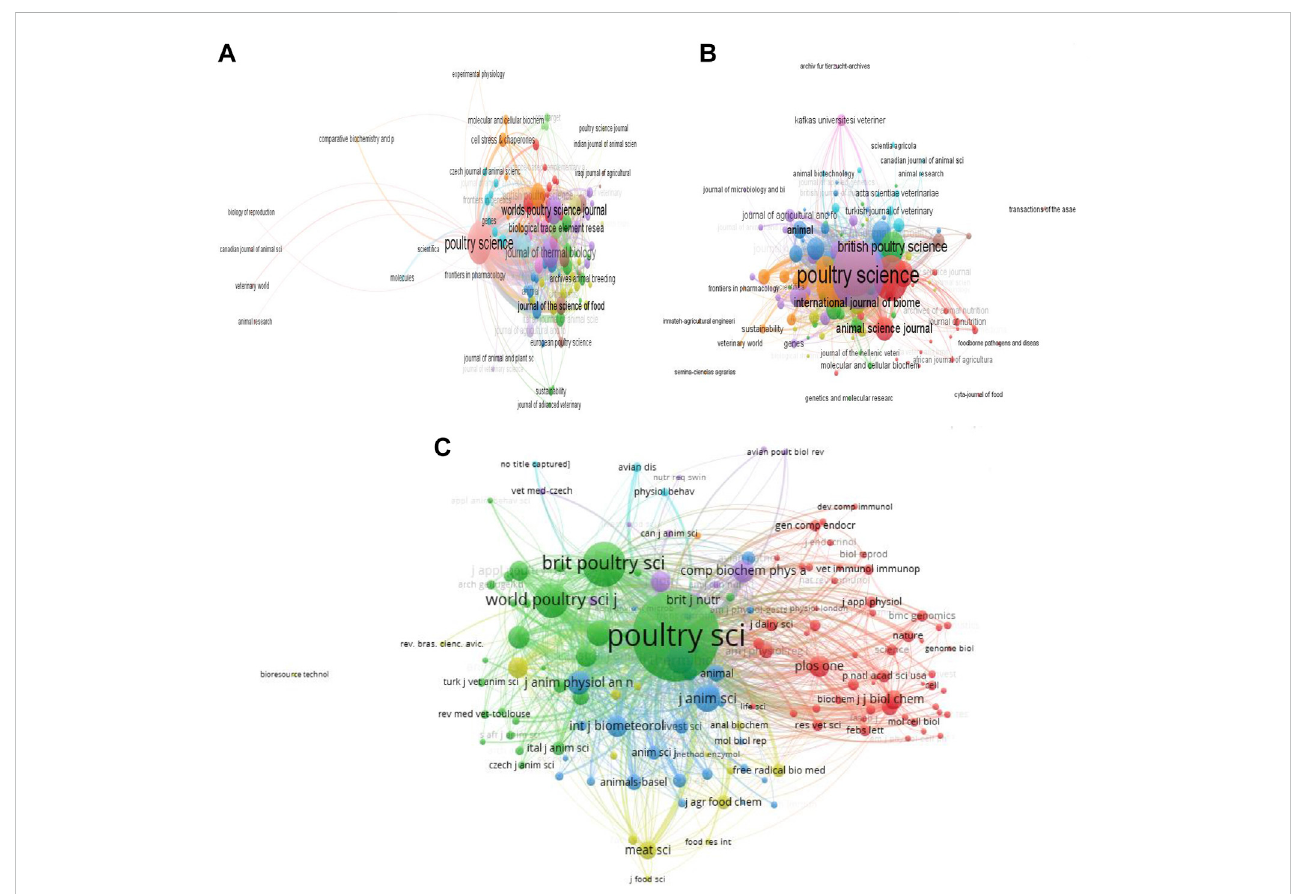
FIGURE 6 Journals contributing to research on heat stress inpoultry. (A) Citation analysis ofsources. (B) Bibliographic coupling of sources. (C) Co-citation analysis of cited sources. The larger the node, the greater the journal ’ s contribution, and the thicker the line, the greater the link strength between two